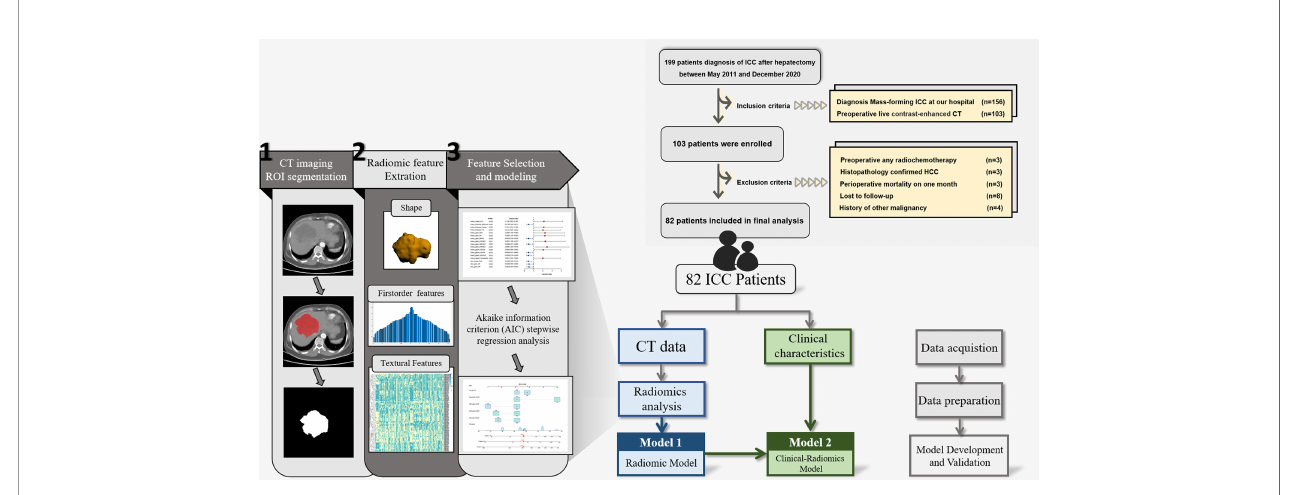
FIGURE 1 | Flow chart of the